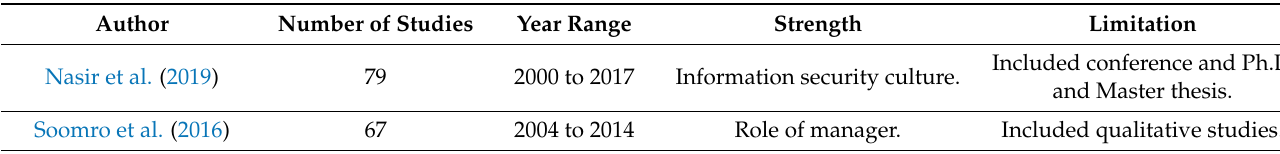
Table 1. Previous review studies of cybersecurity/information